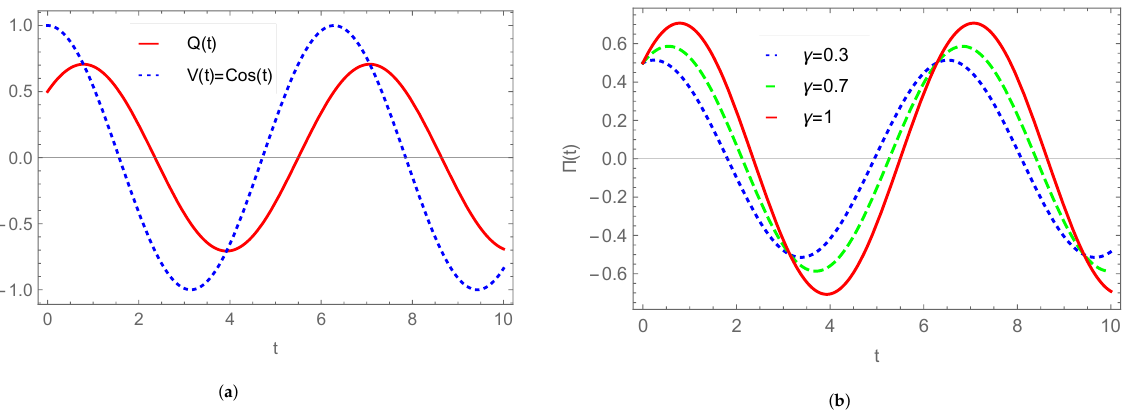
Figure 7. Solutions of RC circuit (38) in ordinary and fractional cases with initial function f ( . ) = cos ( . ) . ( a ) Potential across the capacitor (40) ( Q ( t ) ) and external potential ( V ( t ) ); ( b ) Fractional case for potential across the capacitor ( Π ( t ) ) for different values of γ